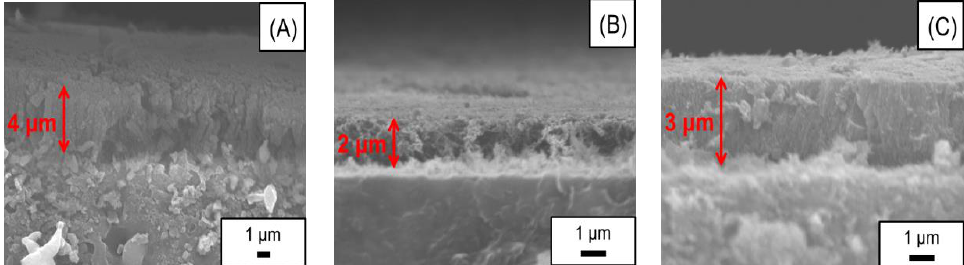
Figure 4. Cross sectional view of TiO 2 thin films deposited at ( A ) He = 5L/min + H 2 O = 20 mL/min ( B ) He = 5L/min + Ar = 50 mL/min +H 2 O = 20mL/min and ( C ) He = 5L/min + Ar = 300 mL/min + H 2 O = 20mL/min; using atmospheric pressure plasma jet.